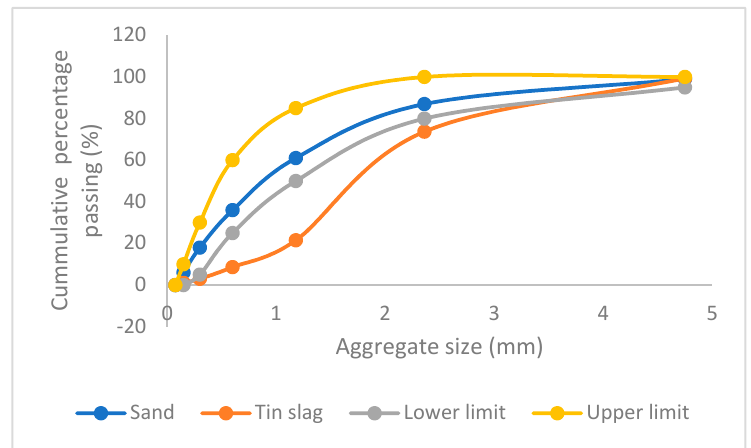
Figure 2. Initial sieve analysis.